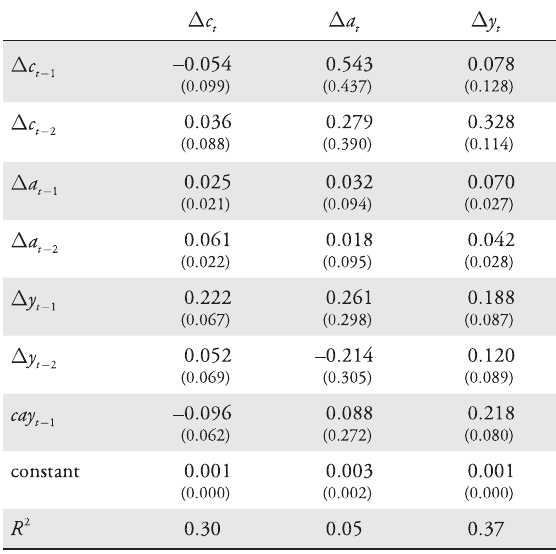
Table 2: Short-Run Responses to cay Residual from